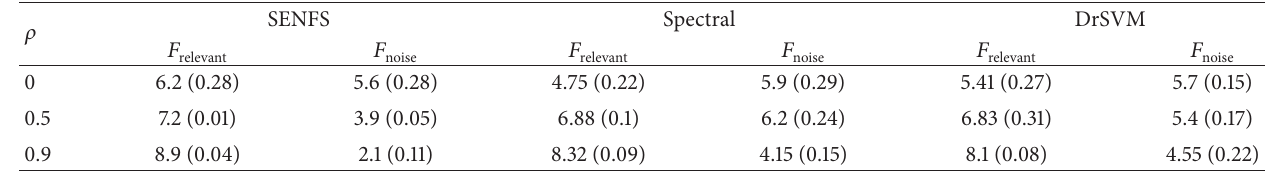
Table 1: Comparisons of selected features and their standard errors (in parenthesis). 𝐹 𝐹 is the number of selected noise features. noise